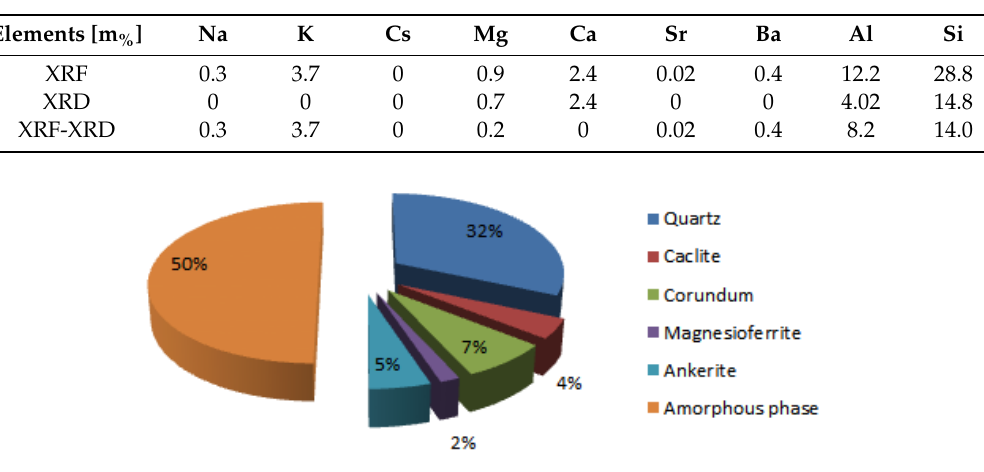
Figure 1. SEM micrographs of green waste ceramic. ( a ) General picture with rock-like particles; ( b ) aggregate. Table 3. Mass percentage of elements measured with XRF (m %XRF , first row), mass percentage of elements determined with Rietveld refinement from XRD (m %XRD , second row), mass percentage of